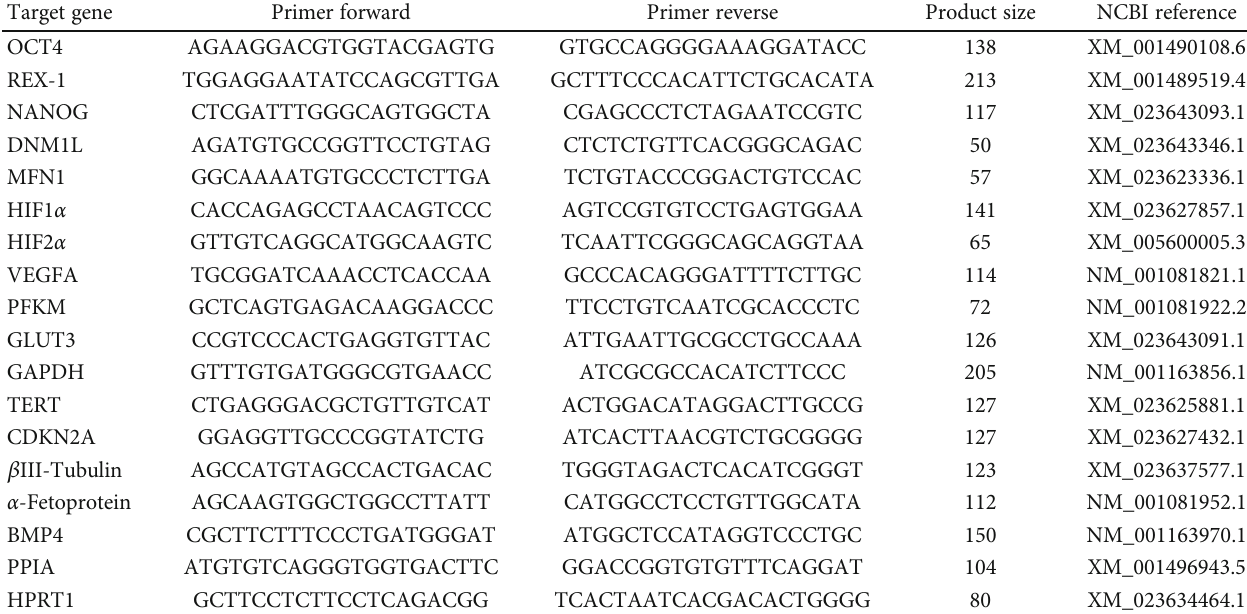
Table 1: Primer sequences used for the detection of pluripotency, senescence, embryoid body evaluation, and genes involved in metabolism, lower oxygen tension, and mitochondrial